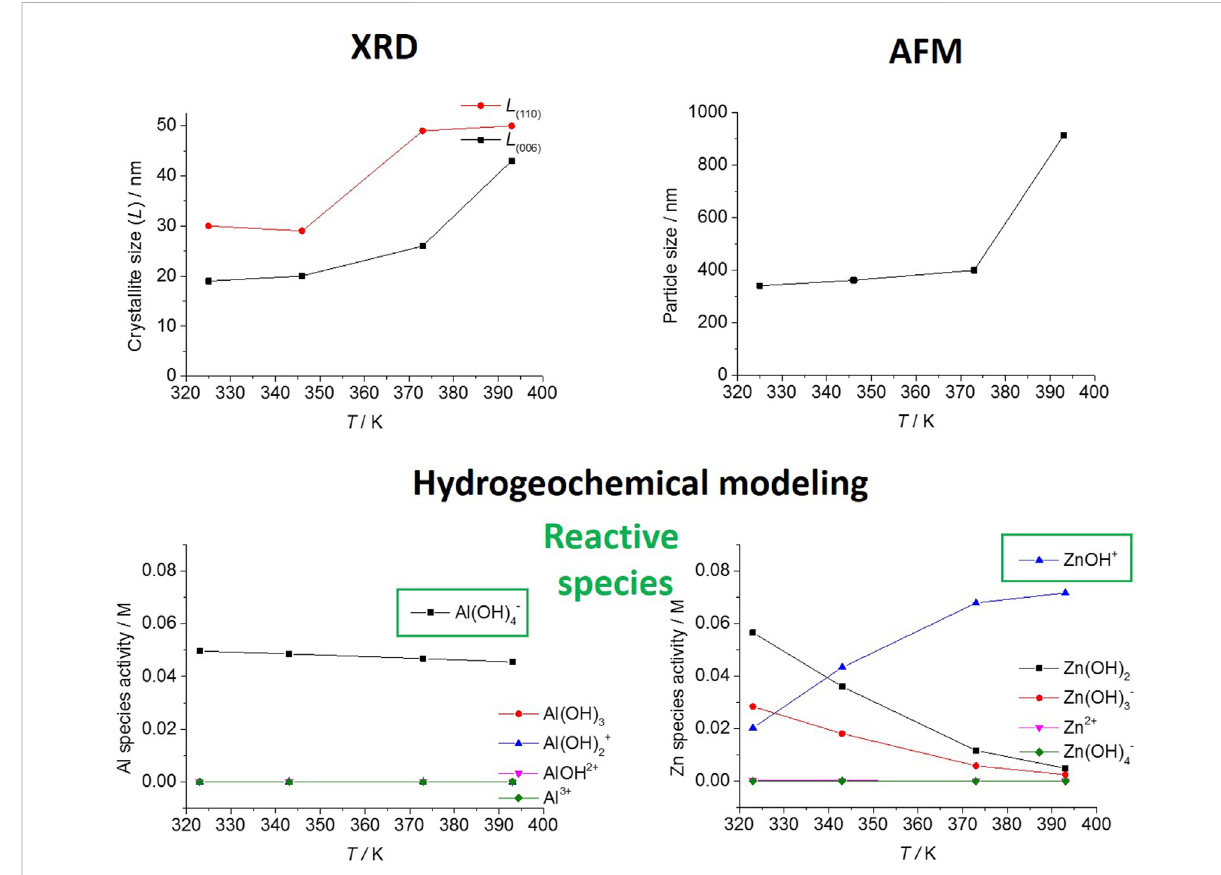
FIGURE 11 Main reactive species obtained from hydrogeochemical modelling were used to understand the optimal crystallite (XRD) and particle sizes (AFM) for a ZnAl LDH at temperatures in the range 320 – 400 K and exempli fi ed herein for pH = 10. Images adapted from reference (Galvão et al.,